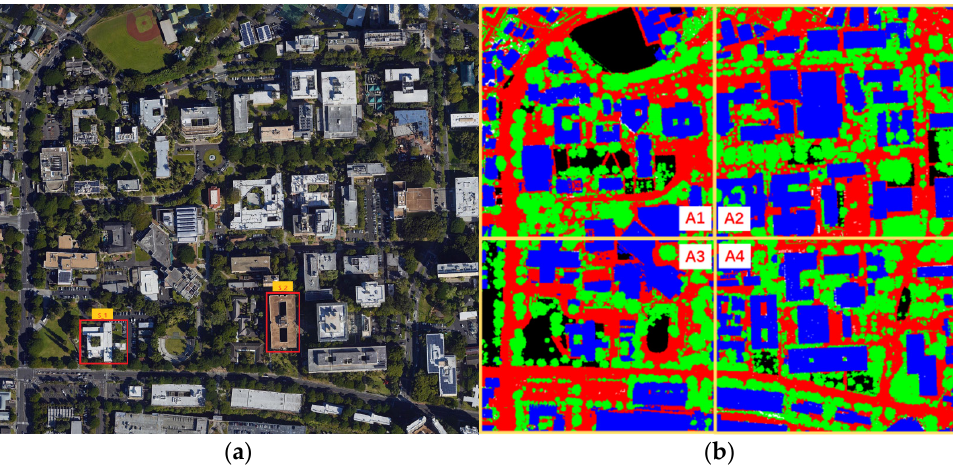
Figure 2. Experimental data sources: ( a ) optical image; ( b ) top view of ALS LiDAR point